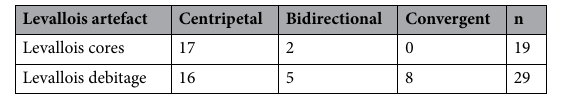
Table 4. Dorsal scar pattern (where identifiable) on Levallois